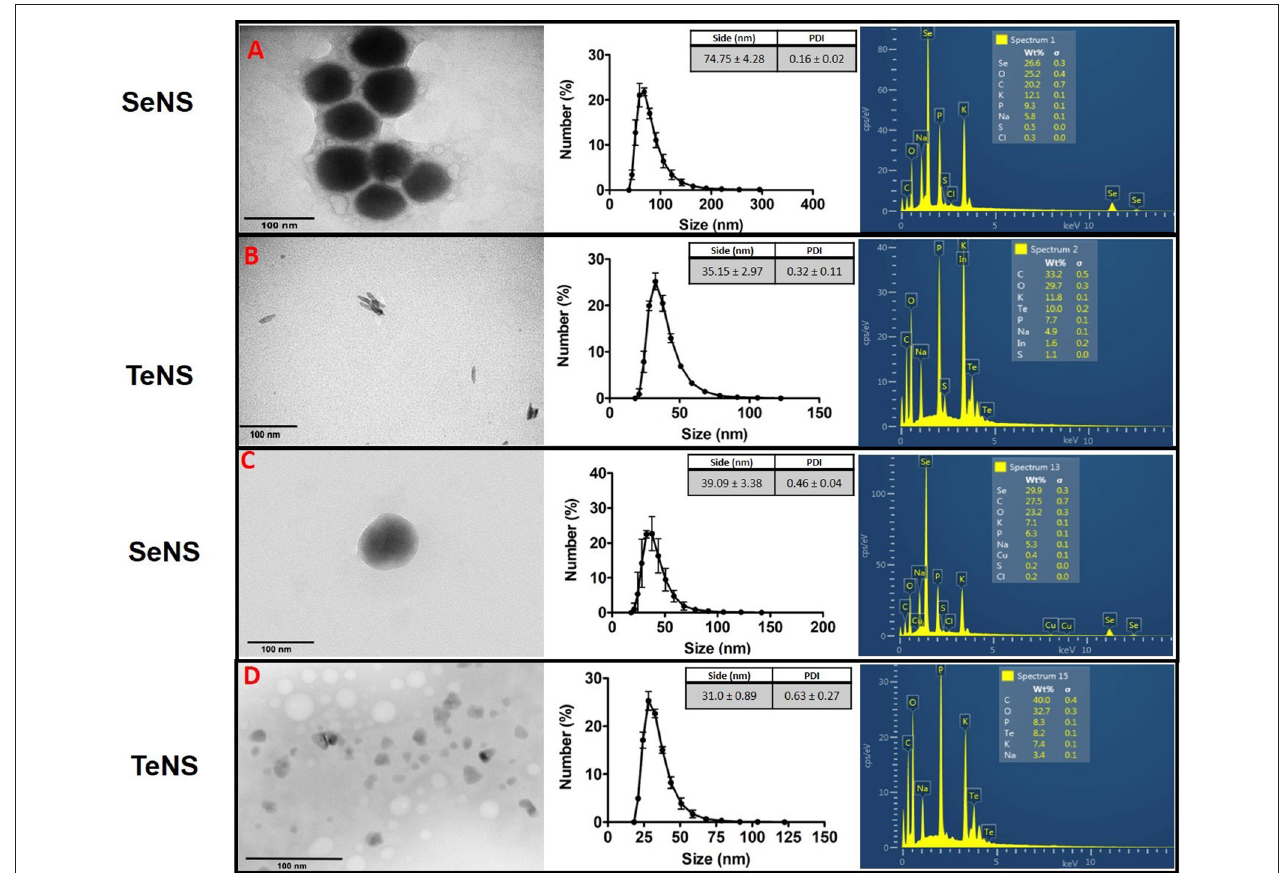
FIGURE 6 | Characterization of GorA-synthesized NS. Electron micrographs (left), dynamic light scattering (middle), and EDS (right). Whereas the SeNS (A) and TeNS (B) were generated using purified GorA, SeNS (C) and TeNS (D) were generated using crude extracts of E. coli overexpressing the gorA gene. Numbers are the average of 3 independent trials ±